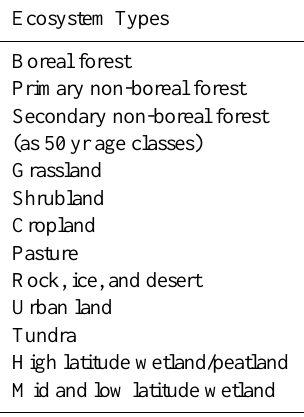
Table 1. Regions used in this study. Table 2. Ecosystem types used in this study (as 50yr age classes).